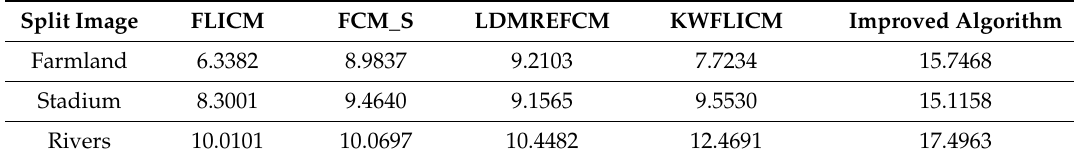
Table 11. The PSNR (dB) comparison between di ff erent algorithms against mixed noise. Split Image FLICM FCM_S LDMREFCM KWFLICM Improved Algorithm Farmland